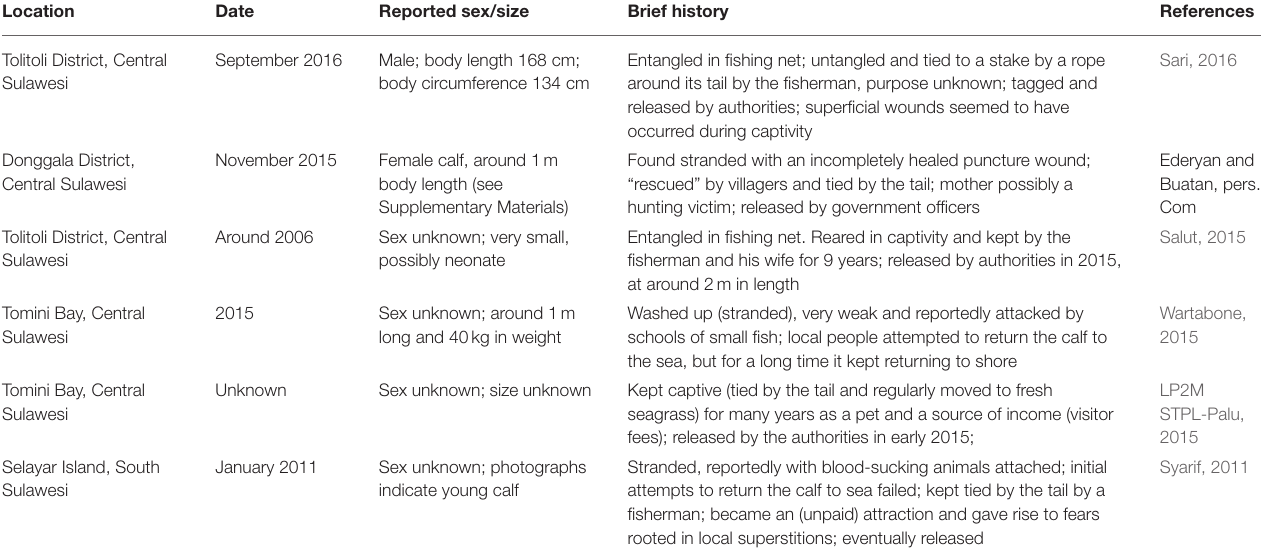
TABLE 4 | Six Dugong by-catch and stranding cases in Central and South Sulawesi.